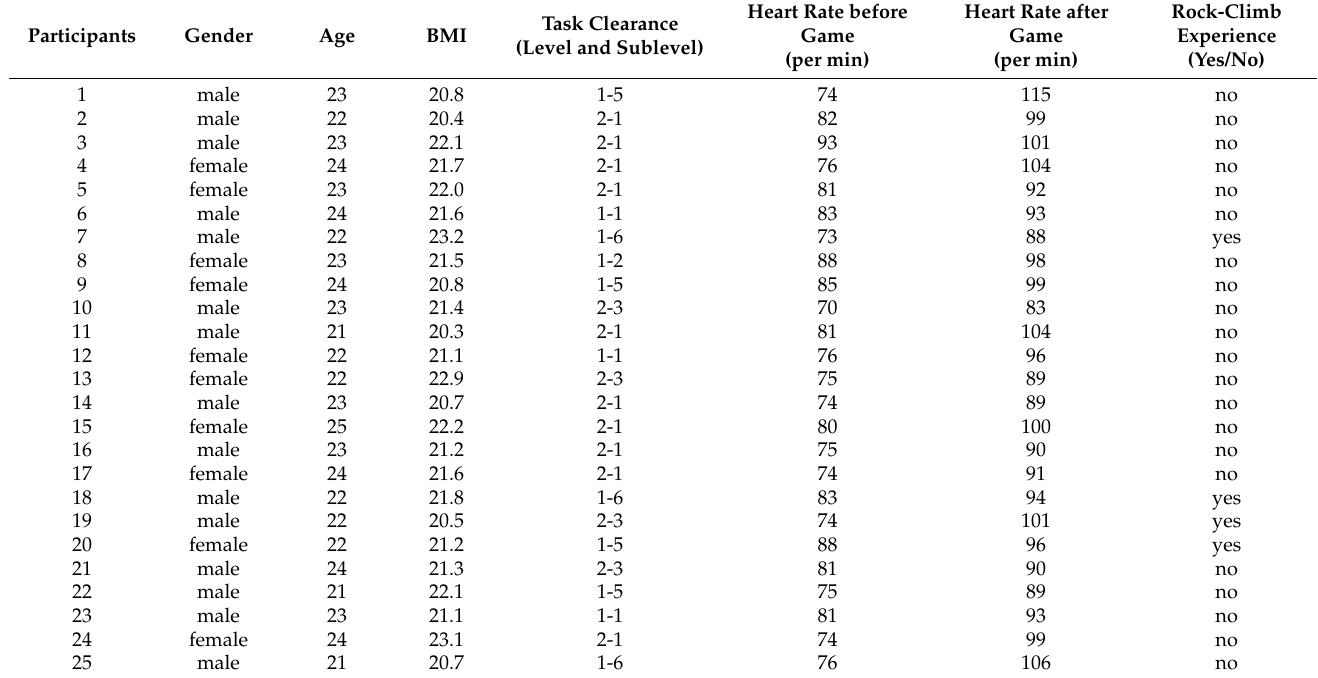
Table 1. Statistics of the